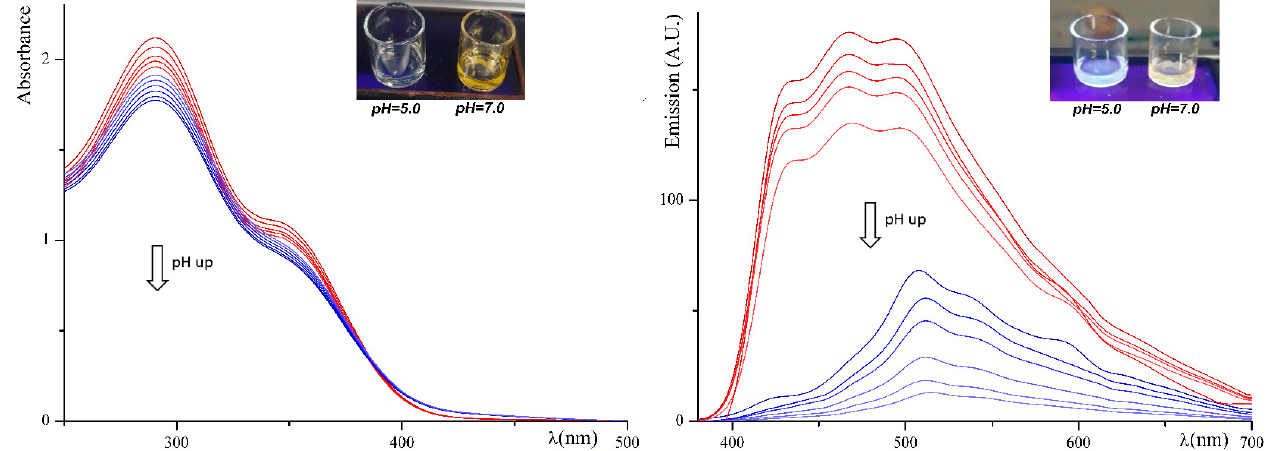
Figure 1. UV–visible spectral titration of C1 1.00 mM in water using Britton–Robinson buffers from pH = 4.0 to pH = 9.0 by gradients of 0.5 pH units (on the left). Fluorescence spectral titration of C1 1.00 mM in water using Britton–Robinson buffers from pH = 4.0 to pH = 9.0 by gradients of 0.5 pH units (on the right), excitation wavelength of 280 nm. In the insets: the same water solutions used to register the absorbance and emission spectra in natural light (on the left) and under a standard UV-lamp at 254 nm (on the right) at two different pH values.